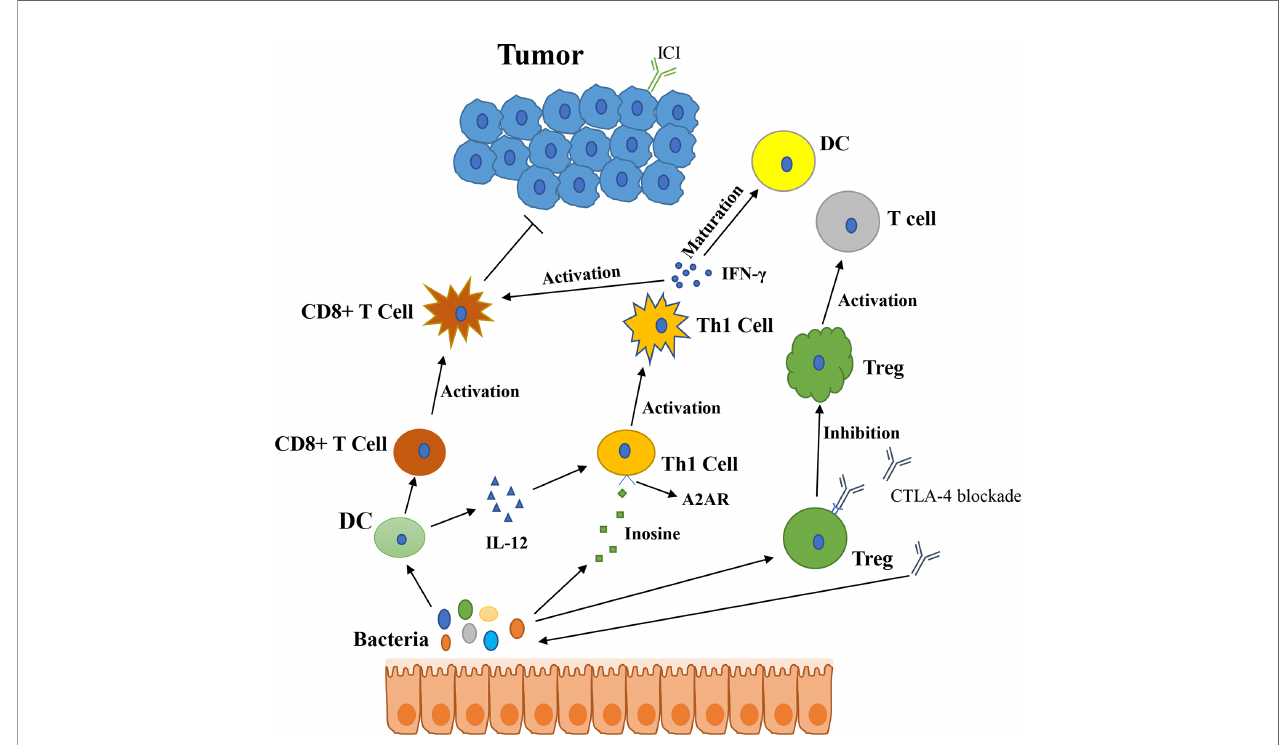
FIGURE 2 | The potential mechanism of gut microbiota modulating the ef fi cacy of ICIs (1). Bacteroides thetaiotaomicron or Bacteroides fragilis enhances T cell response, treatment of anti-CTLA-4 blockade in fl uences the abundance of immunogenic Bacteroides spp., which will in turn enhance immune response of T cells (2); Bacteroides fragilis induces Th1 immune response, promotes the maturation of dendritic cell (3); Bi fi dobacterium improves function of DC, results in activating of CD8+ T cell and enhancing anti-PD-L1 antitumor effect (4); The metabolite inosine of gut microbiota activates Th1 cell and increases level of IFN- g , which can enhance antitumor effect in vivo (5); Microbiota composition affects IL-12-independent Th1 cell immune response (6); CTLA-4 blockade induces the inactivation of CTLA-4+ Treg cells, leads to activating of effector T cell and enhancing antitumor